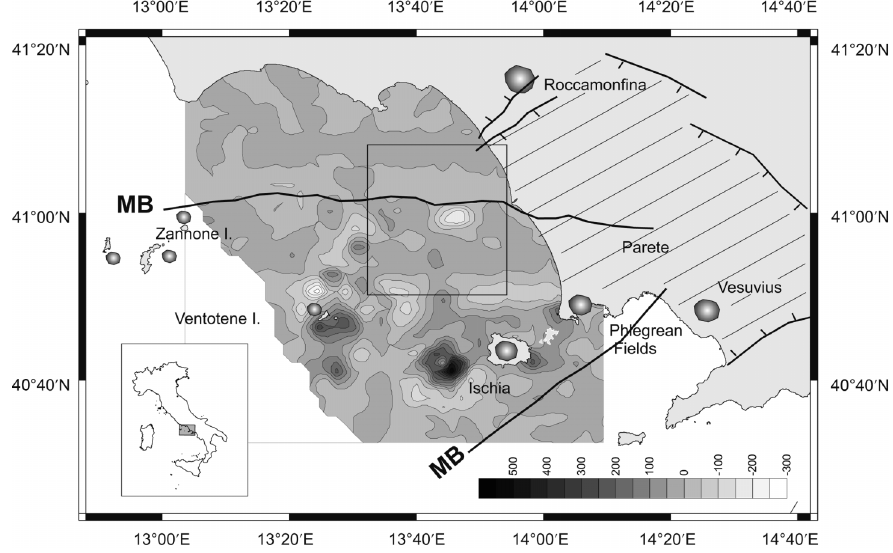
Fig. 1. Location of the surveyed area (outlined) in the frame of the Campania offshore along the Eastern Tyrrhenian margin at 41°N. Filled, gray-scale contour represents the aeromagnetic anomaly field with scale bar in nT. Note the two sharp Magnetic Boundaries (MB) along the 41°N parallel and across the Bay of Naples defining a triangular region, where most volcanic activity has occurred during Plio-Quaternary. The two mag- netic boundaries converge towards the area of the Parete subsurface volcano. The extension of the fault- bordered Campanian alluvial plain is outlined (oblique texture) as well as subaerial volcanic